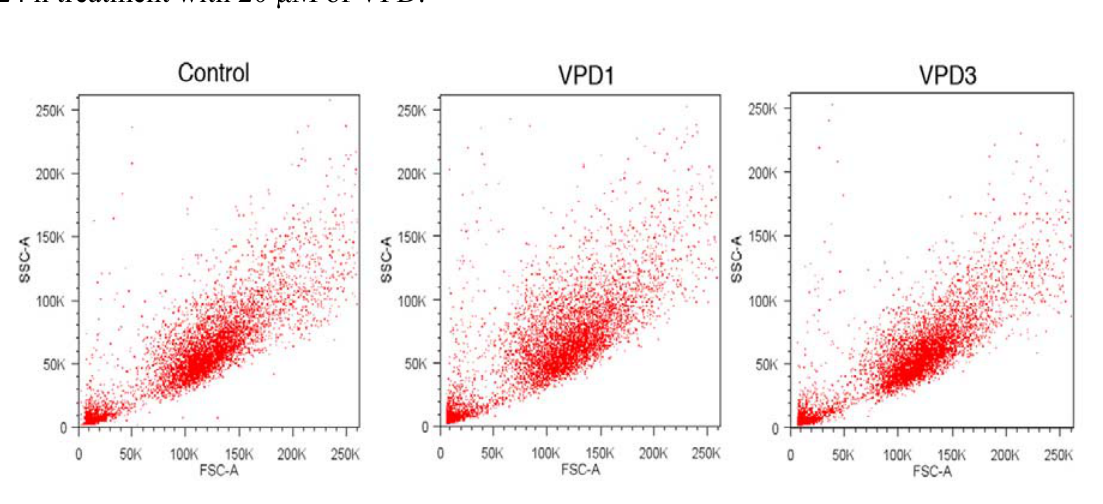
Figure 9. Representative dot plots showing size and granularity of mHippoE-18 cells after 24 h treatment with 20 μ M of